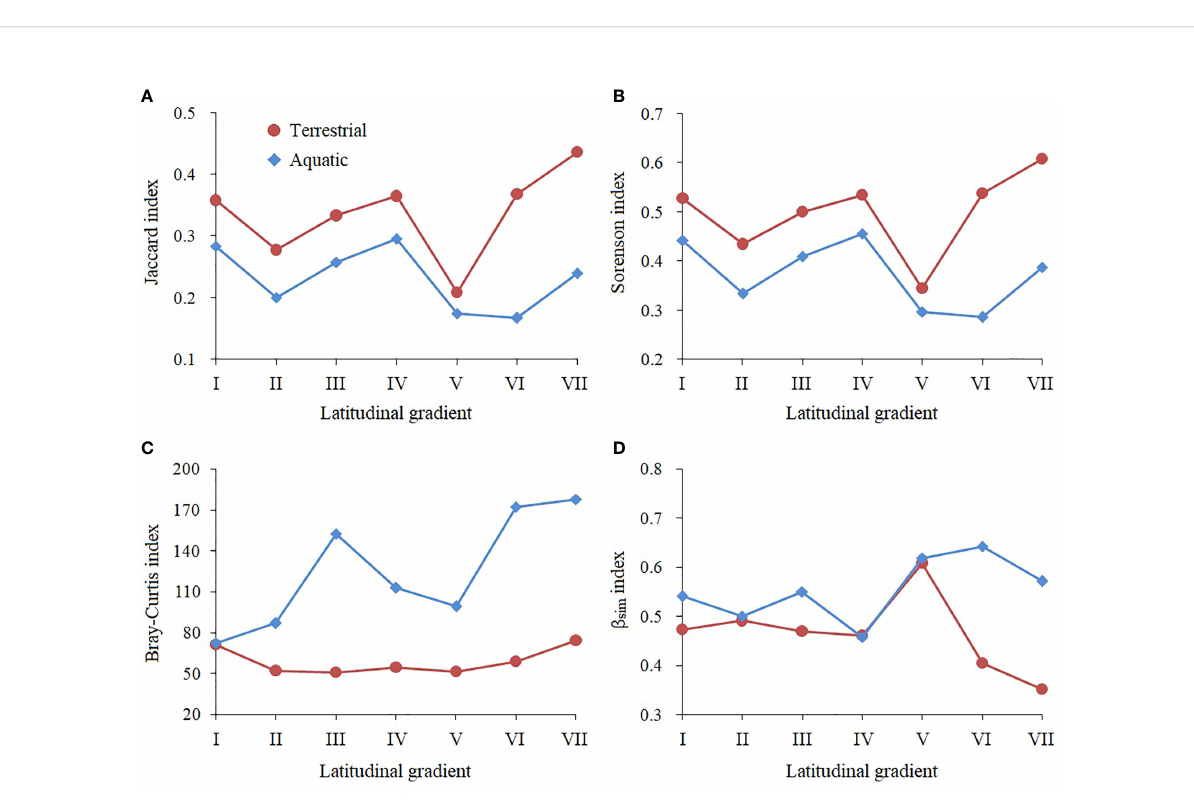
FIGURE 6 Variations in the b diversity index and community similarity index of the A . philoxeroides communities along the latitudinal gradient. Latitudinal gradients I to VII represent the pairwise comparison between the A . philoxeroides community across latitudinal Clusters 1 to 8. (A, B) represent the community similarity, (C, D) represent the b